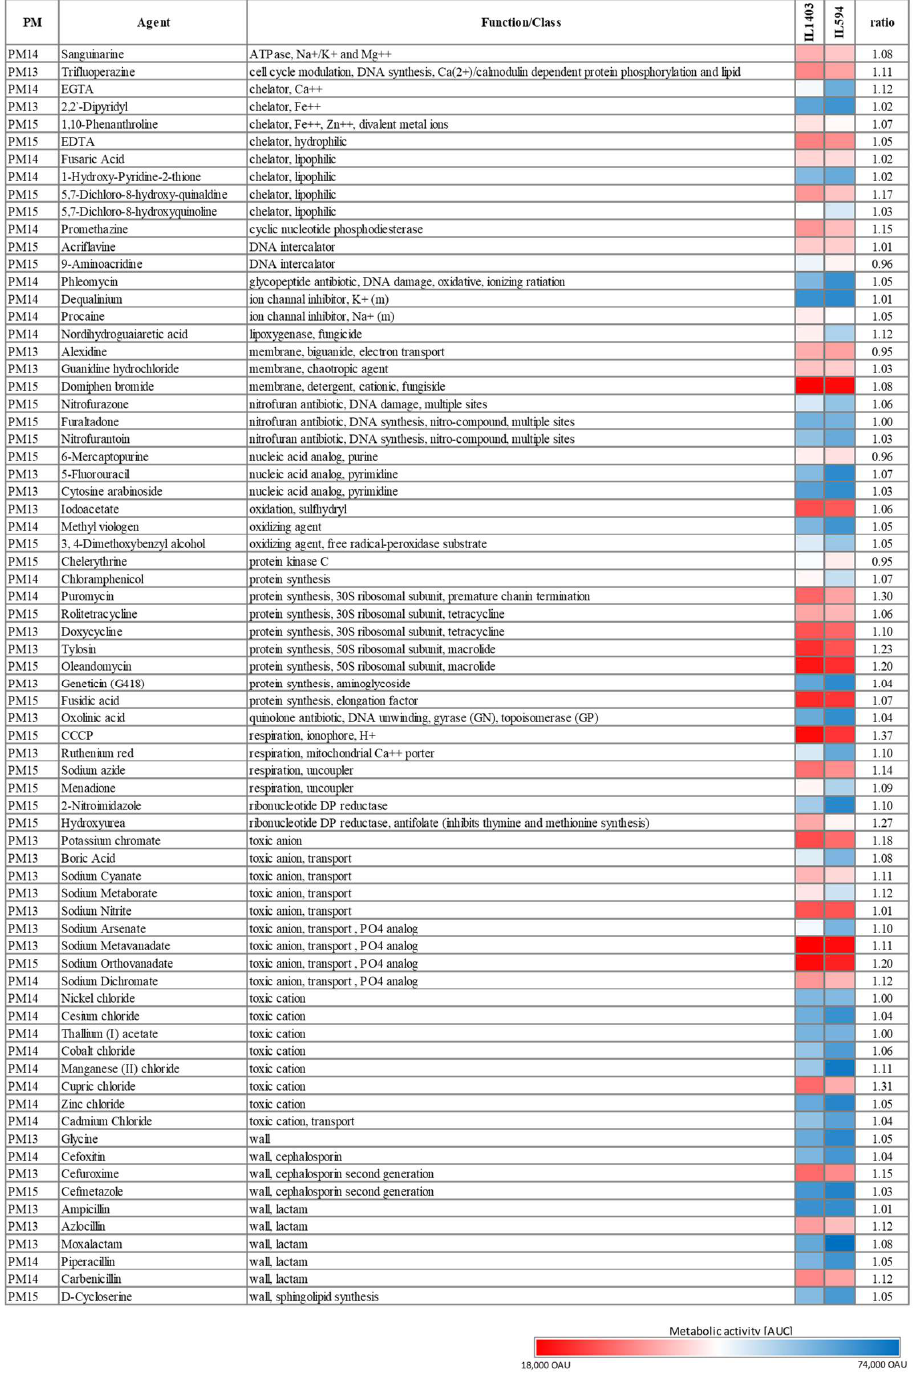
Figure 2. Tolerance of L. lactis IL1403 and IL594 to various chemical compounds. Colours indicate mean values of the areas under the curve (AUC) of the metabolic activity of IL1403 and IL594 recorded at four different compound concentrations. The highest average metabolic activity recorded was 74,000 OAU (Omnilog Arbitrary Units) and the lowest 18,000 OAU. The ratio was calculated as the quotient of the metabolic activity of IL594 and IL1403.